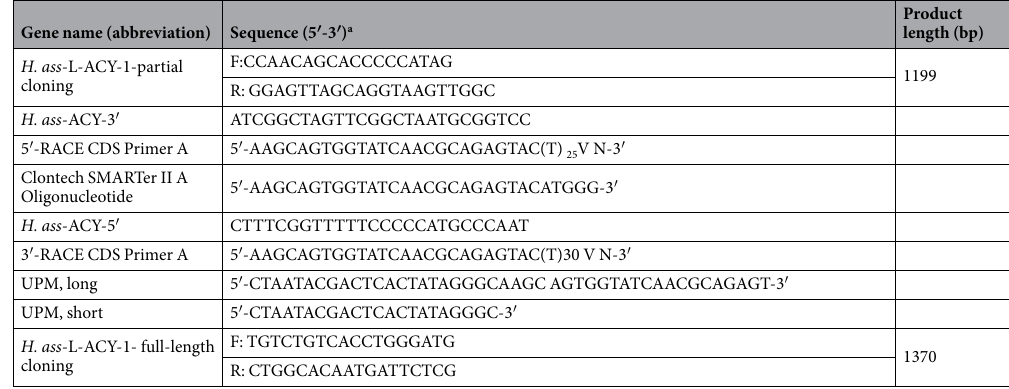
Table 1. Primer pairs used for cloning of H. assulta L-ACY-1. a F and R respectively indicate forward primer and reverse primer.